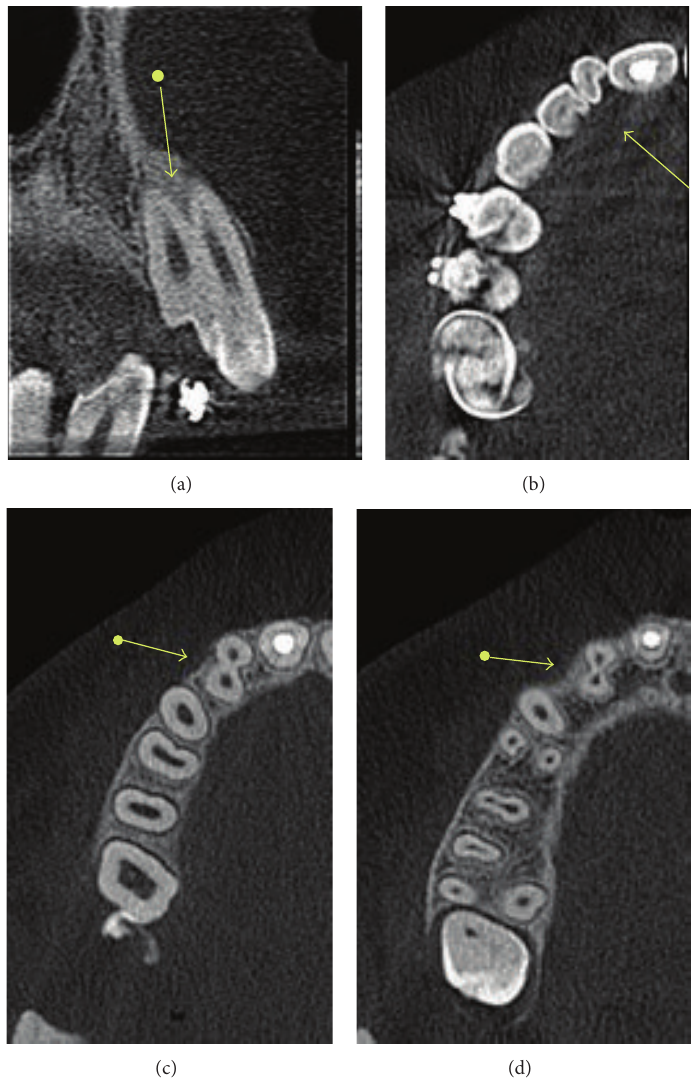
Figure 3: (a) Cross section of the cone beam computed tomography (CBCT) reveals the union of the right maxillary lateral incisor and the supernumerary tooth at the dentin level and shows the extent and limits of the anomaly, suggesting dental fusion. Axial sections of the CBCT show signs of fusion in the (b) cervical third, (c) middle third, and (d) apical third of the